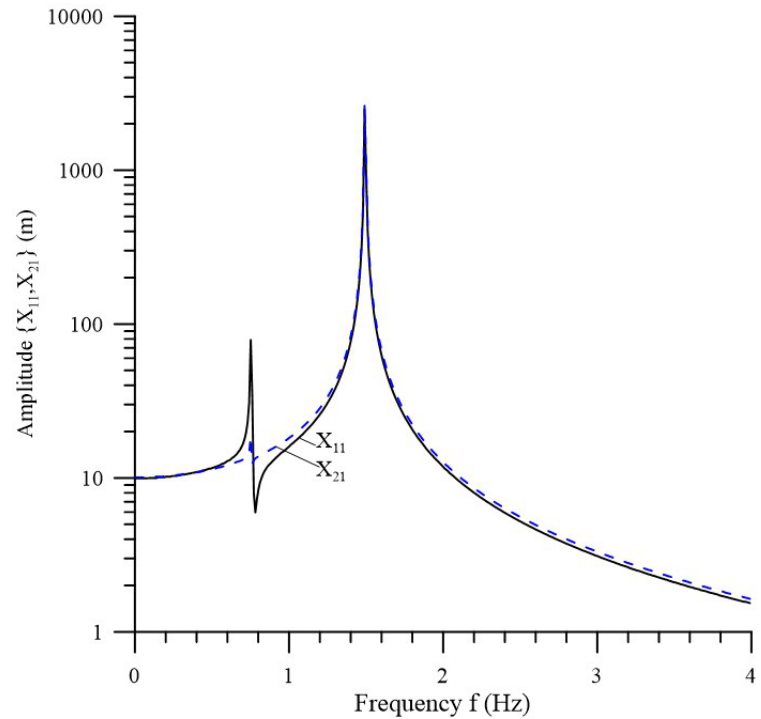
Figure 6. Effect of wave frequency f on { X 11 , X 21 } . ( A 2 = 120 m 2 ; other parameters are the same as those in Figure 4).